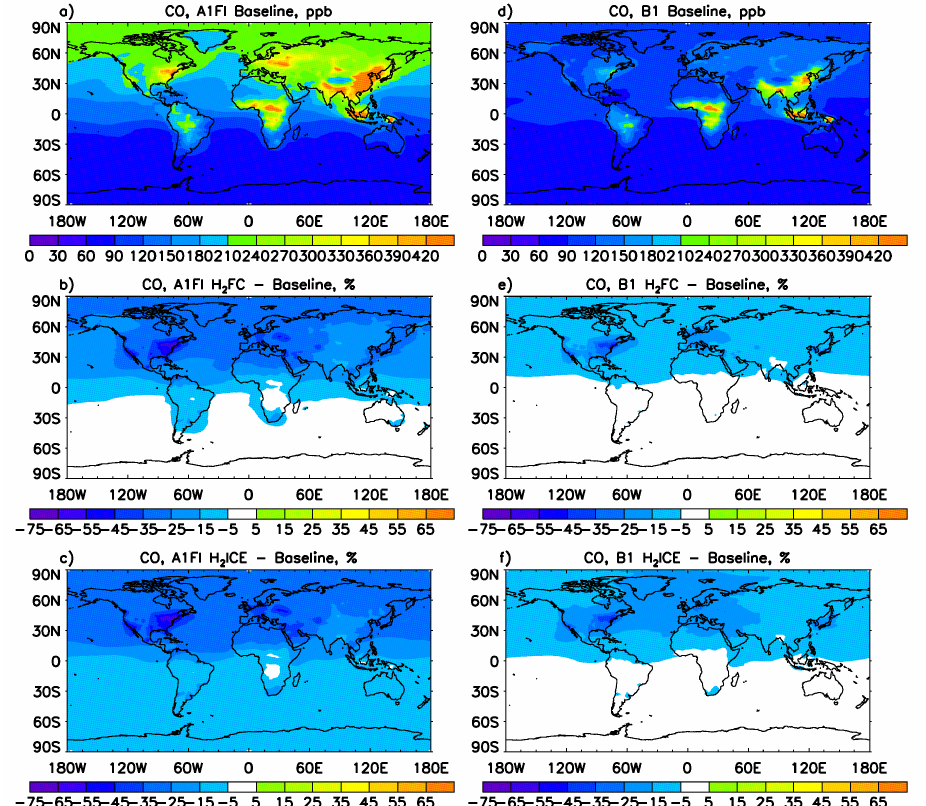
Figure 10. CAM-Chem simulated 2050 annual mean surface CO mixing ratios in the A1FI (a) and B1 (d) baseline scenarios and percent differences for the H 2 fuel cell (H 2 -FC) and H 2 internal combustion engine (H 2 -ICE) scenarios (b, c, e, f) . Note the different scales.